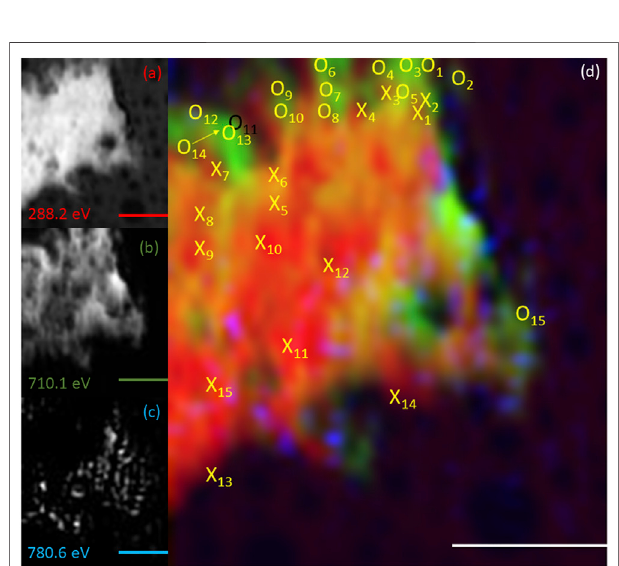
FIGURE 8 | Elemental maps for the 72 h timepoint for (A) C K -edge (288.2 eV; red), (B) Fe L 2,3 -edge (710.1 eV; green) and (C) Co L 2,3 -edge (780.6.0 eV; blue). The corresponding composite RGB (red, green, blue) image (D) shows the spatial relationship between the bacterial cells (C K -edge) and the minerals (Fe and Co L 2,3 -edges). Spectra were taken from regionsco-locatedwiththebacterialcells(X)andregionsnotco-locatedtothe bacterialcell(O).Thecentreofthe ‘ X ’ and ‘ O ’ denotethepreciselocationfrom which the spectra were collected. All scale bars are 3 μ